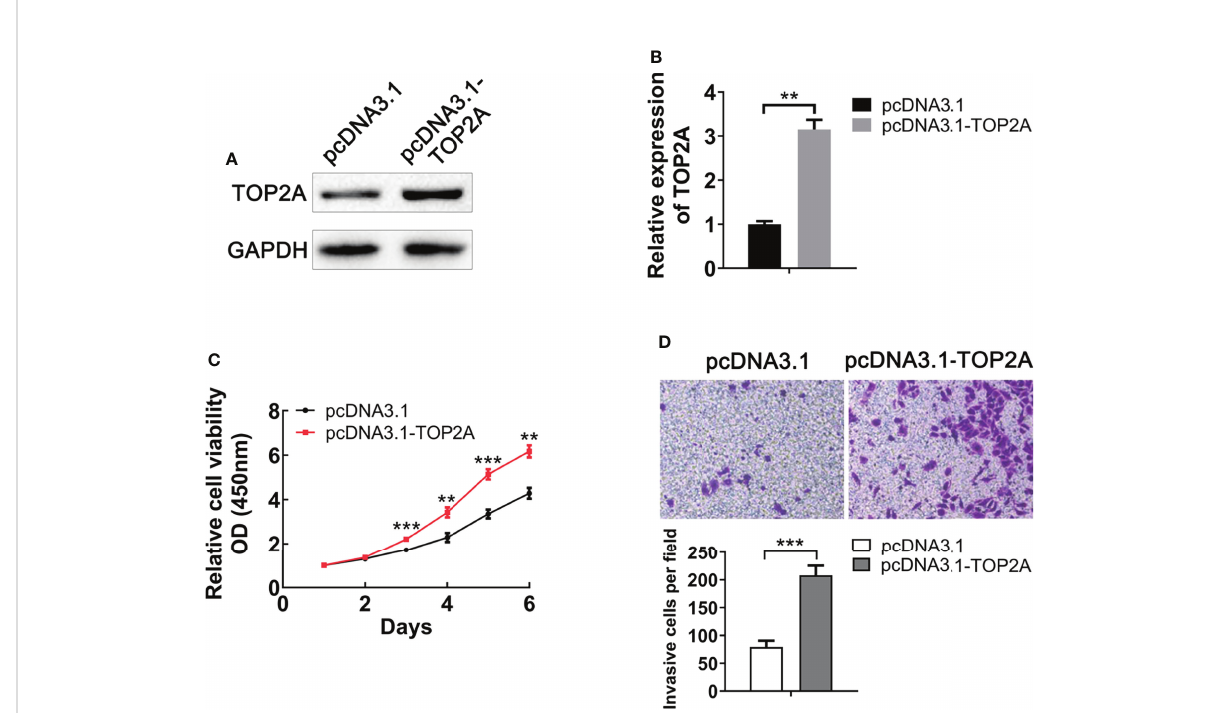
FIGURE 4 Upregulation of TOP2A promotes MB cell proliferation and invasion. (A) The expression of TOP2A was detected by western blot analysis after transfecting Daoy cells with pcDNA3.1-TOP2A. (B) Semi-quantitative densitometric analysis was used to measure the relative levels of TOP2A. **P<0.01. (C) CCK-8 assay was used to detect the proliferation ability of pcDNA3.1-TOP2A-transfected Daoy cells. **P<0.01, ***P<0.001. (D) Transwell assays precoated with Matrigel Matrix were performed to assess the invasive ability of pcDNA3.1-TOP2A-transfected Daoy cells.